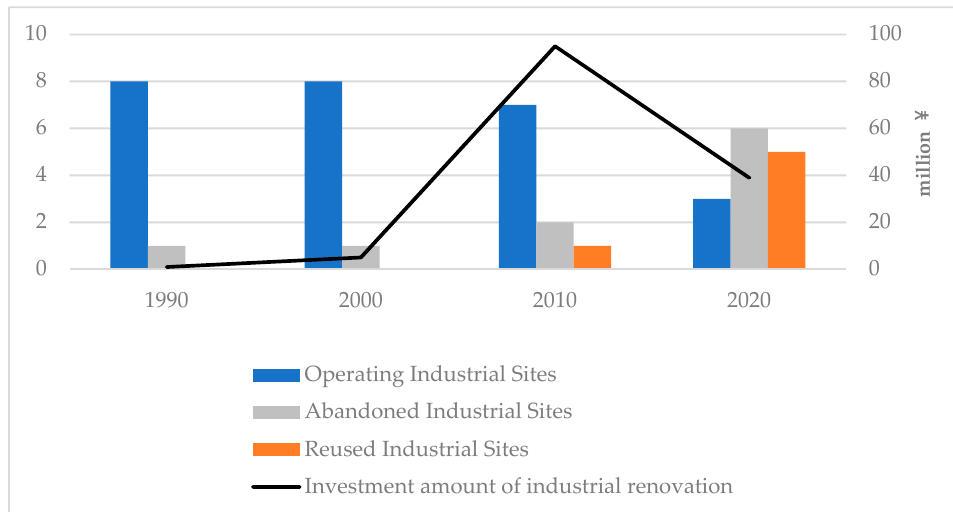
Figure 13. The change in the relationship between the operation state of labor-intensive industries and the investment amount of industrial renovation over time (Figure source: own drawing; data from: [83]).